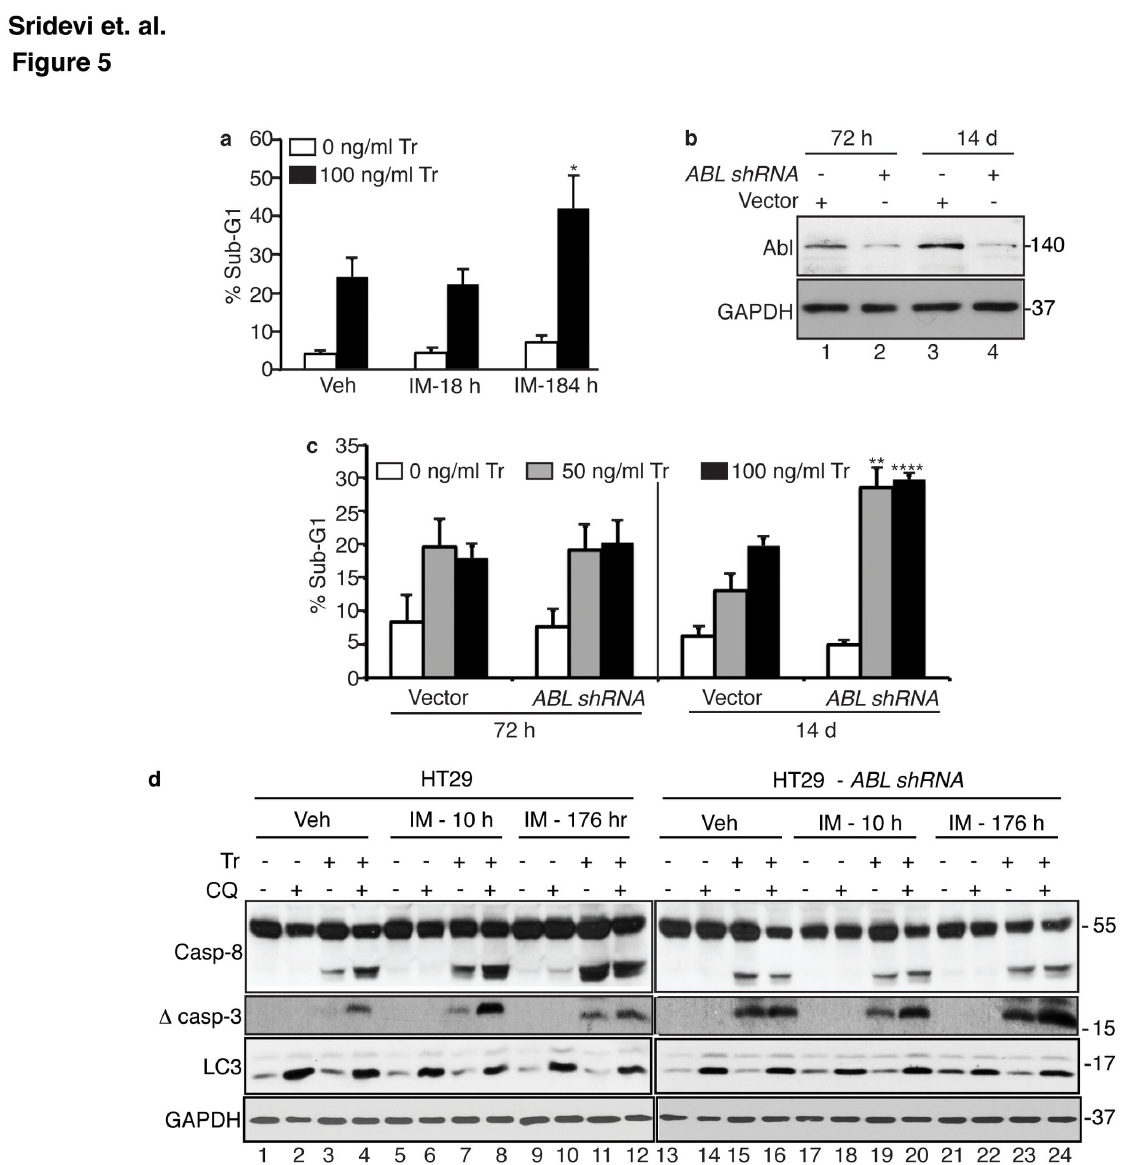
Figure 5. Persistent inhibition of ABL tyrosine kinase is required to enhance TRAIL-induced apoptosis. a. Short-term vs. long-term effect of imatinib on TRAIL-induced sub-G1 response. HT29 cells treated with vehicle (Veh, PBS) or imatinib (IM, 2 µM). The IM-18 hr cells were pre-treated with IM for 2 hr before adding TRAIL (Tr, 100 ng/ml, 16 hr). The IM-184 hr cells were pre-treated with IM for 7 days (168 hr) with daily addition of IM before adding TRAIL. Values shown are mean and standard deviation from 3 independent experiments. * = p <